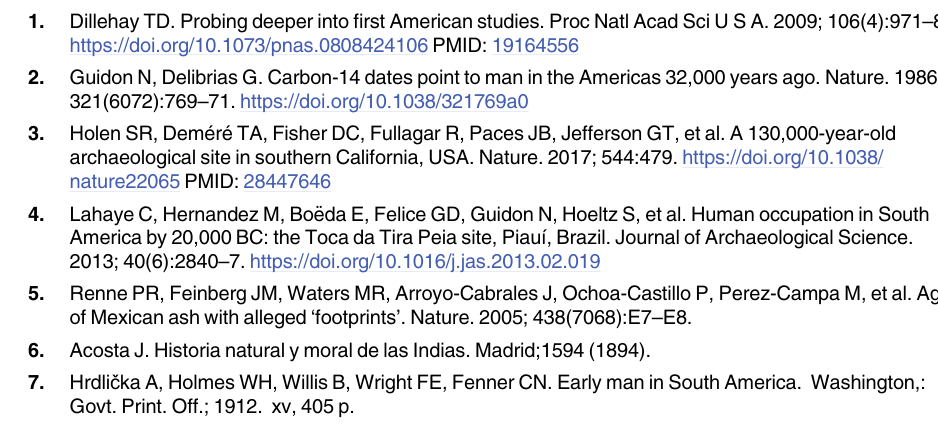
S1 Table. Landmark coordinates for each Quintana Roo